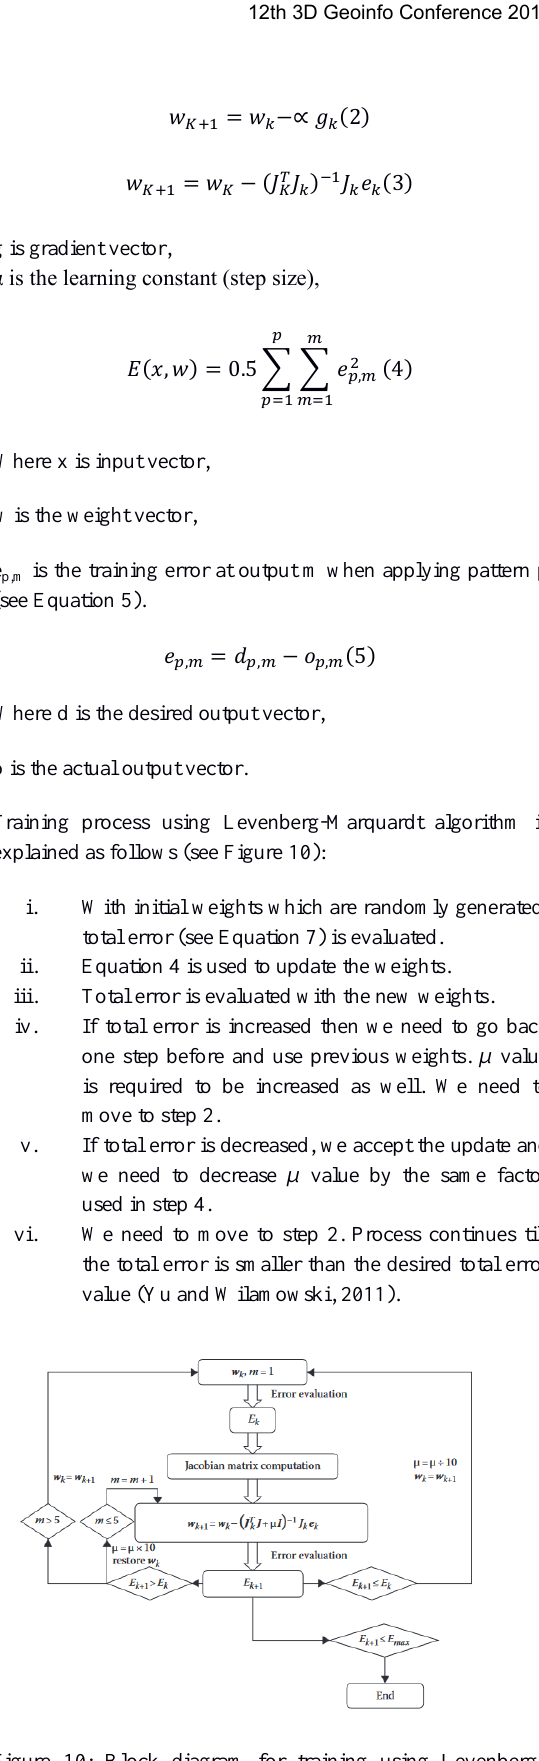
Figure 10: Block diagram for training using Levenberg– Marquardt algorithm: wk is the current weight, wk+1 is the